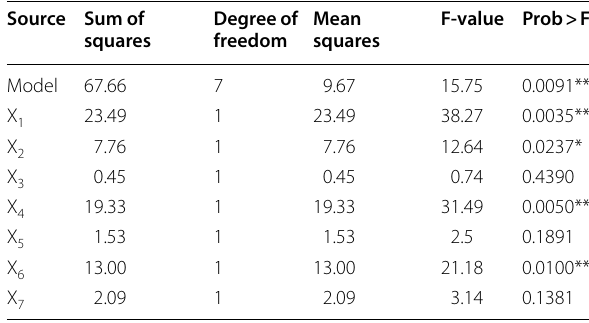
Table 1 Plackett-Burman experiment analysis results of